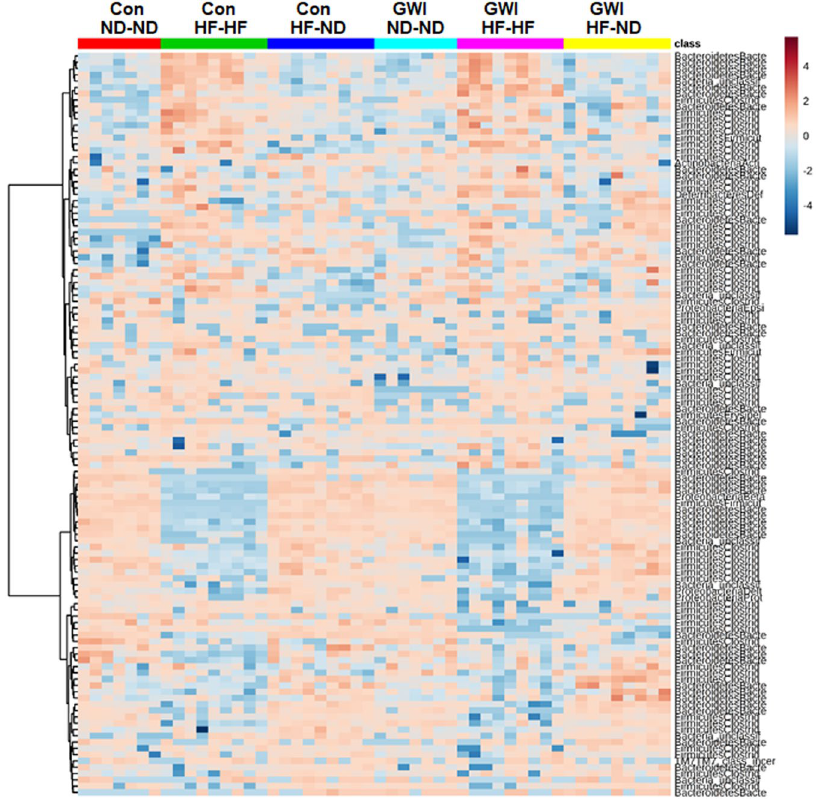
Figure 5. Heat map illustrating patterns in OTU relative abundance among the treatment groups. All subjects in each group are arrayed in columns and bacterial taxonomies are indicated in rows. Con = control; GWI = PER + PB; ND = normal diet; HF = HF diet. Clustering along the y-axis was done using the Ward